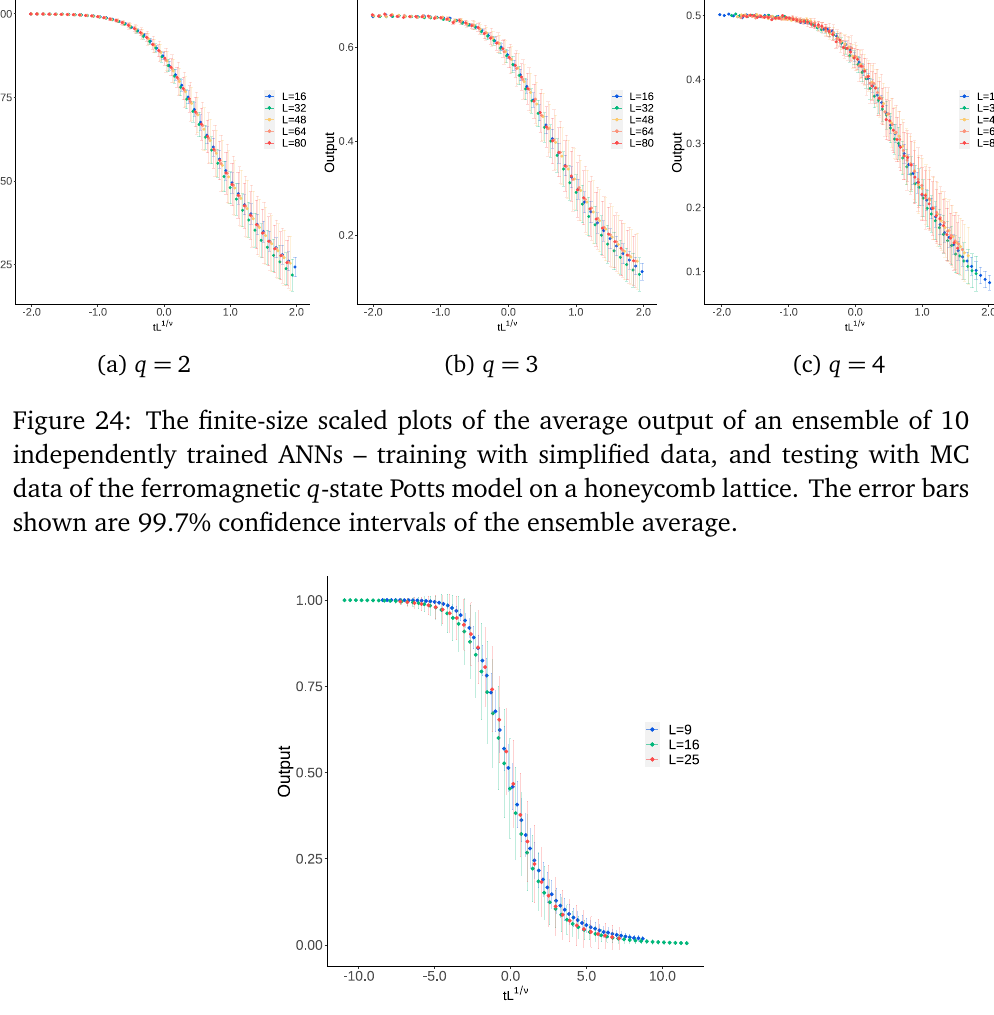
Figure 25: q = 2: The finite-size scaled plot of the average output of an ensemble of 10 independently trained ANNs – training with simplified data, and testing with MC data of the ferromagnetic 2-state Potts model on a cubic lattice. The error bars shown are 99.7% confidence intervals of the ensemble